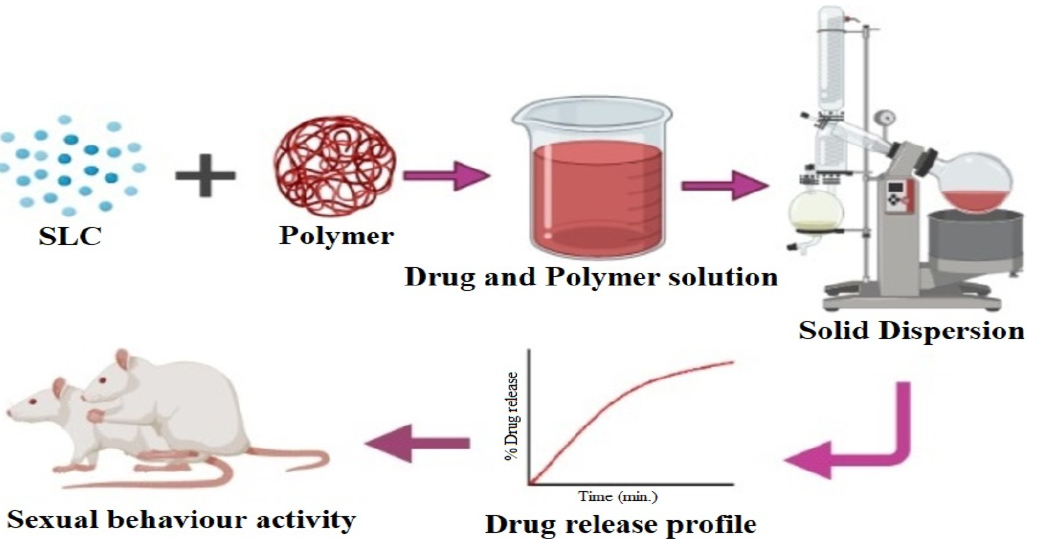
Figure 1. Schematic diagram of preparation of solid dispersion .